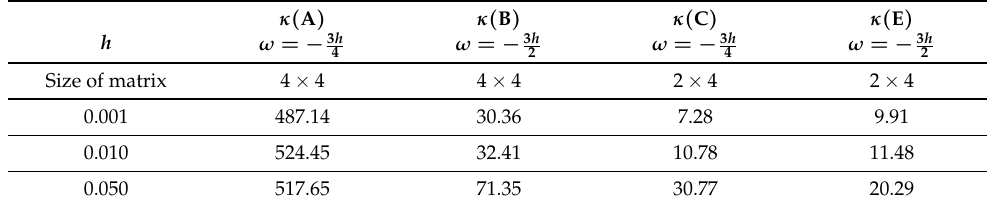
Table 4. Comparison of the condition numbers for the matrices derived from Example